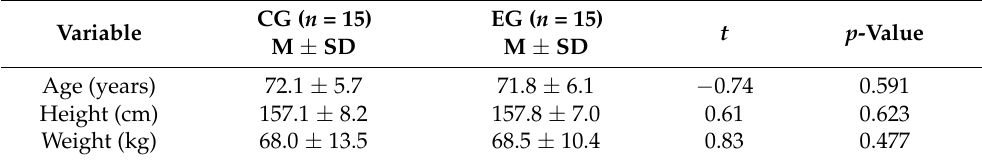
Table 1. Basic participant